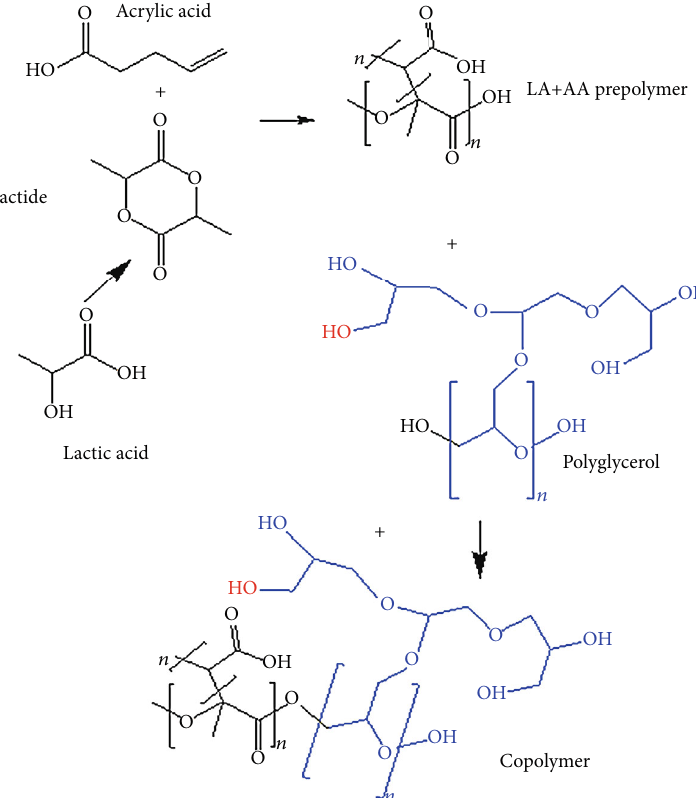
Scheme 1: Schematic representation of the copolymer COP 30 w/w% LA+AA formation from lactic and acrylic acid prepolymerization and the subsequent polymerization with the polyglycerol